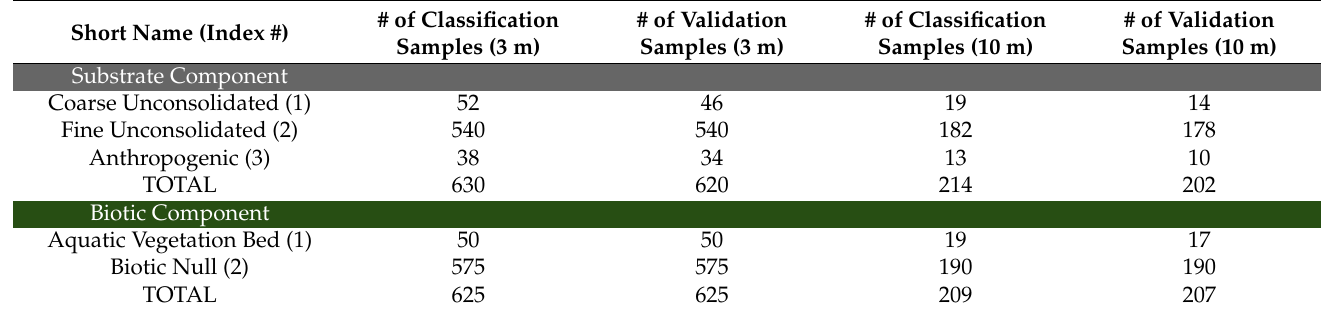
Table 2. Number of ground truth points (samples) for classification and validation used for Tier 1 classification of the 3 m airborne and 10 m satellite data (# =